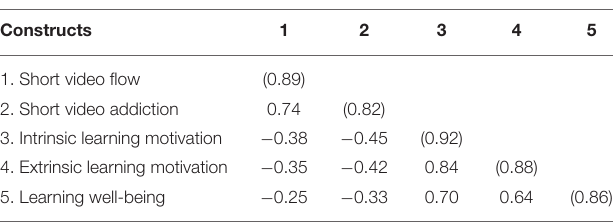
TABLE 2 | Discrimination validity analysis.